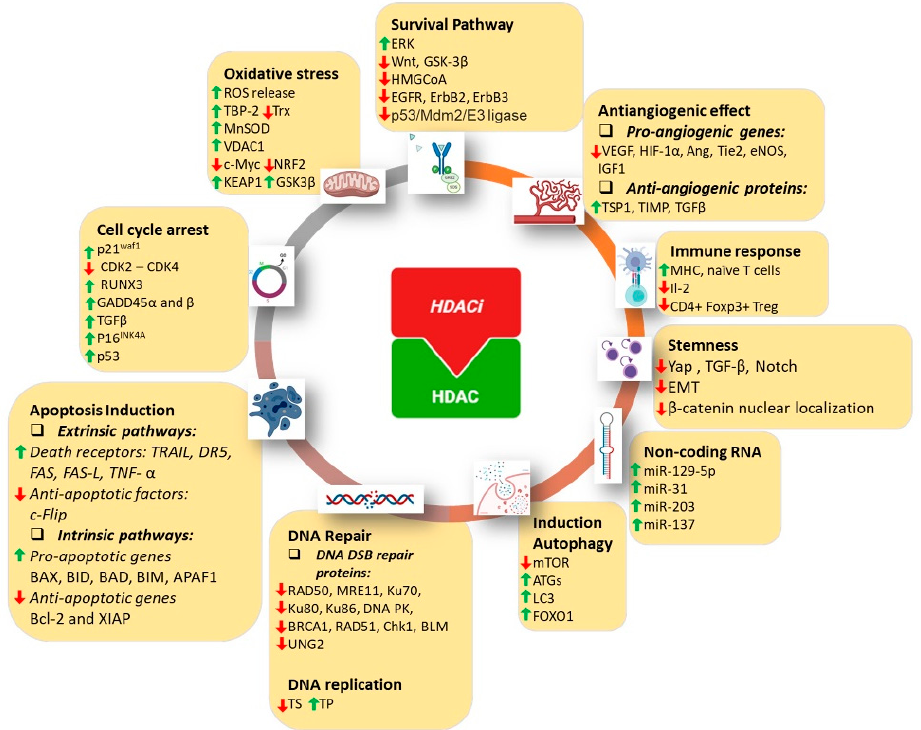
Figure 2. Mechanisms of the anticancer effects of HDAC inhibitors. HDAC inhibitors induced a pleiotropic effect on cancer cells, including modulation of survival pathways, angiogenesis, immune response, stemness, noncoding RNA, autophagy, DNA repair, DNA replication, apoptosis, cell cycle arrest, and oxidative stress.